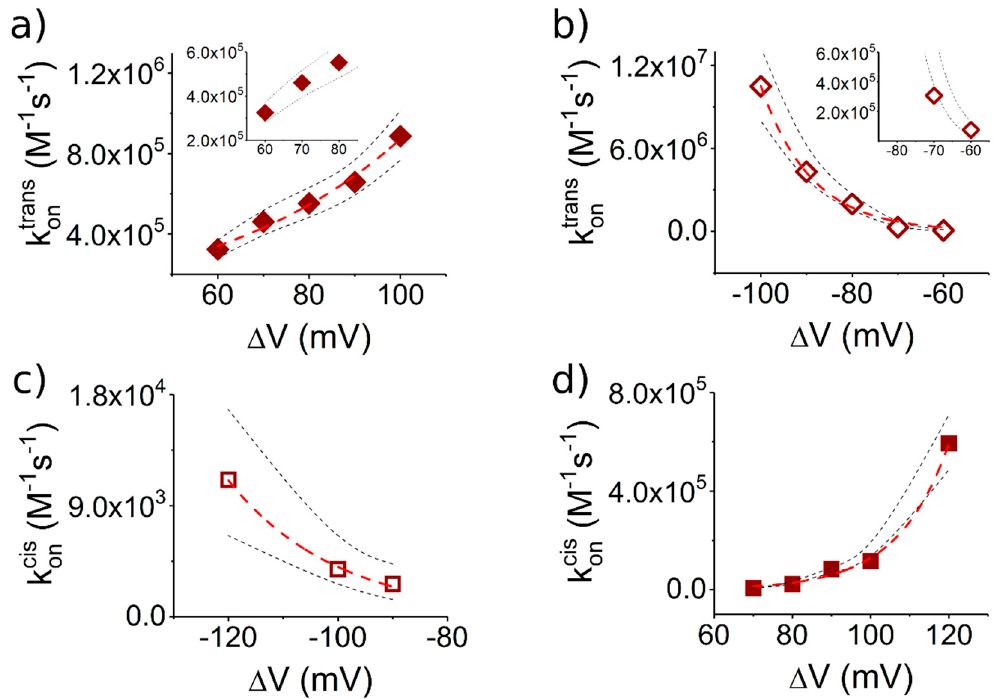
Figure 6. S 6 -containing peptides associate distinctly with the α -HL, depending of the polarity of the applied ∆ V and the side on which they are added ( cis or trans ). All graphs display the voltage-dependent association rate constants ( k on ) of the Pe6 peptide (30 µ M) with the α -HL. As in Figure 5: ( a , b ) the peptides were added to the trans side; and ( c , d ) the peptides were added on the cis side. The red dashed lines represent the best fit of the experimental data (open and filled rectangles) with the equation k on ( ∆ V ) = k on ( 0 ) exp ( a ∆ V ) (see text). The dotted lines represent the upper and lower limits of the 95% confidence intervals for the estimated average values [40].